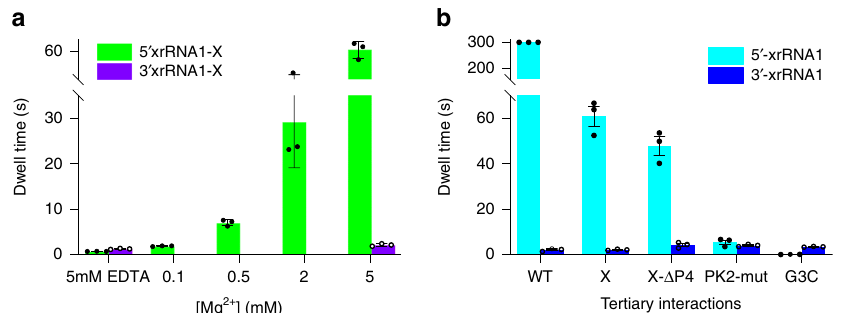
Fig. 5 Mechanical anisotropy of ZIKV xrRNA1 is mainly dictated by its ring-like structure. a Plots of the dwell time for the unfolding and translocation of 5 ′ A36 -xrRNA1-X or 3 ′ A36 -xrRNA1-X in the α -HL nanopore against Mg 2 + concentrations. b Plots of the dwell time for the unfolding and translocation of xrRNA1 mutants in the α -HL nanopore in the presence of 5 mM Mg 2 + . The dwell time for each of 3 independent experiments ( n = 3), the mean and SEM are presented as dot, column, and error bar, respectively. Source data for a and b are provided as a Source Data fi